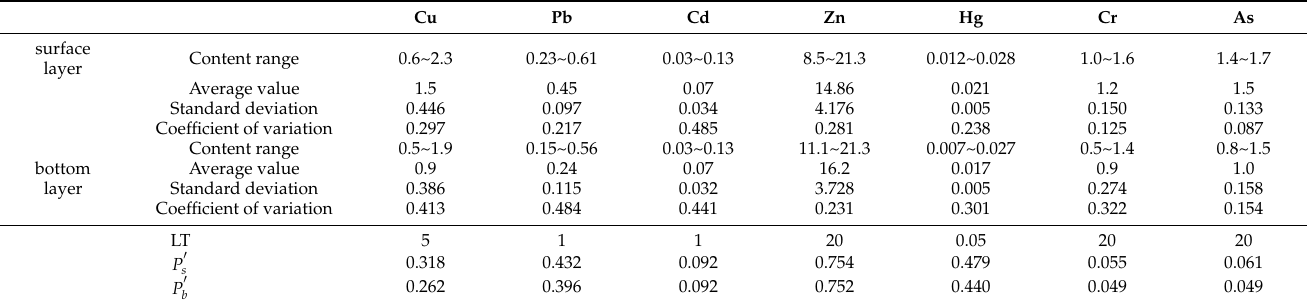
Table 2. Heavy metals concentrations in water from Haikou Bay and adjacent seas. Unit: µ g/L. Cu Pb Cd Zn Hg Cr As